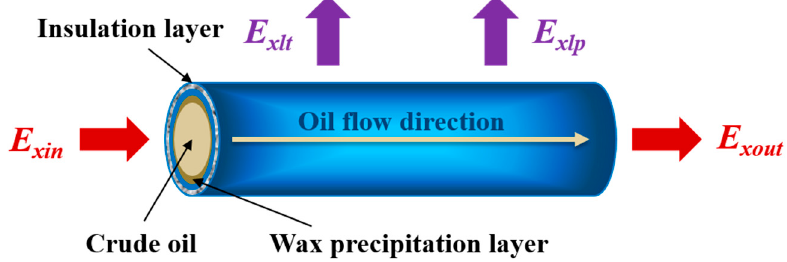
Figure 1. The exergy analysis model in the process of pipeline transportation.